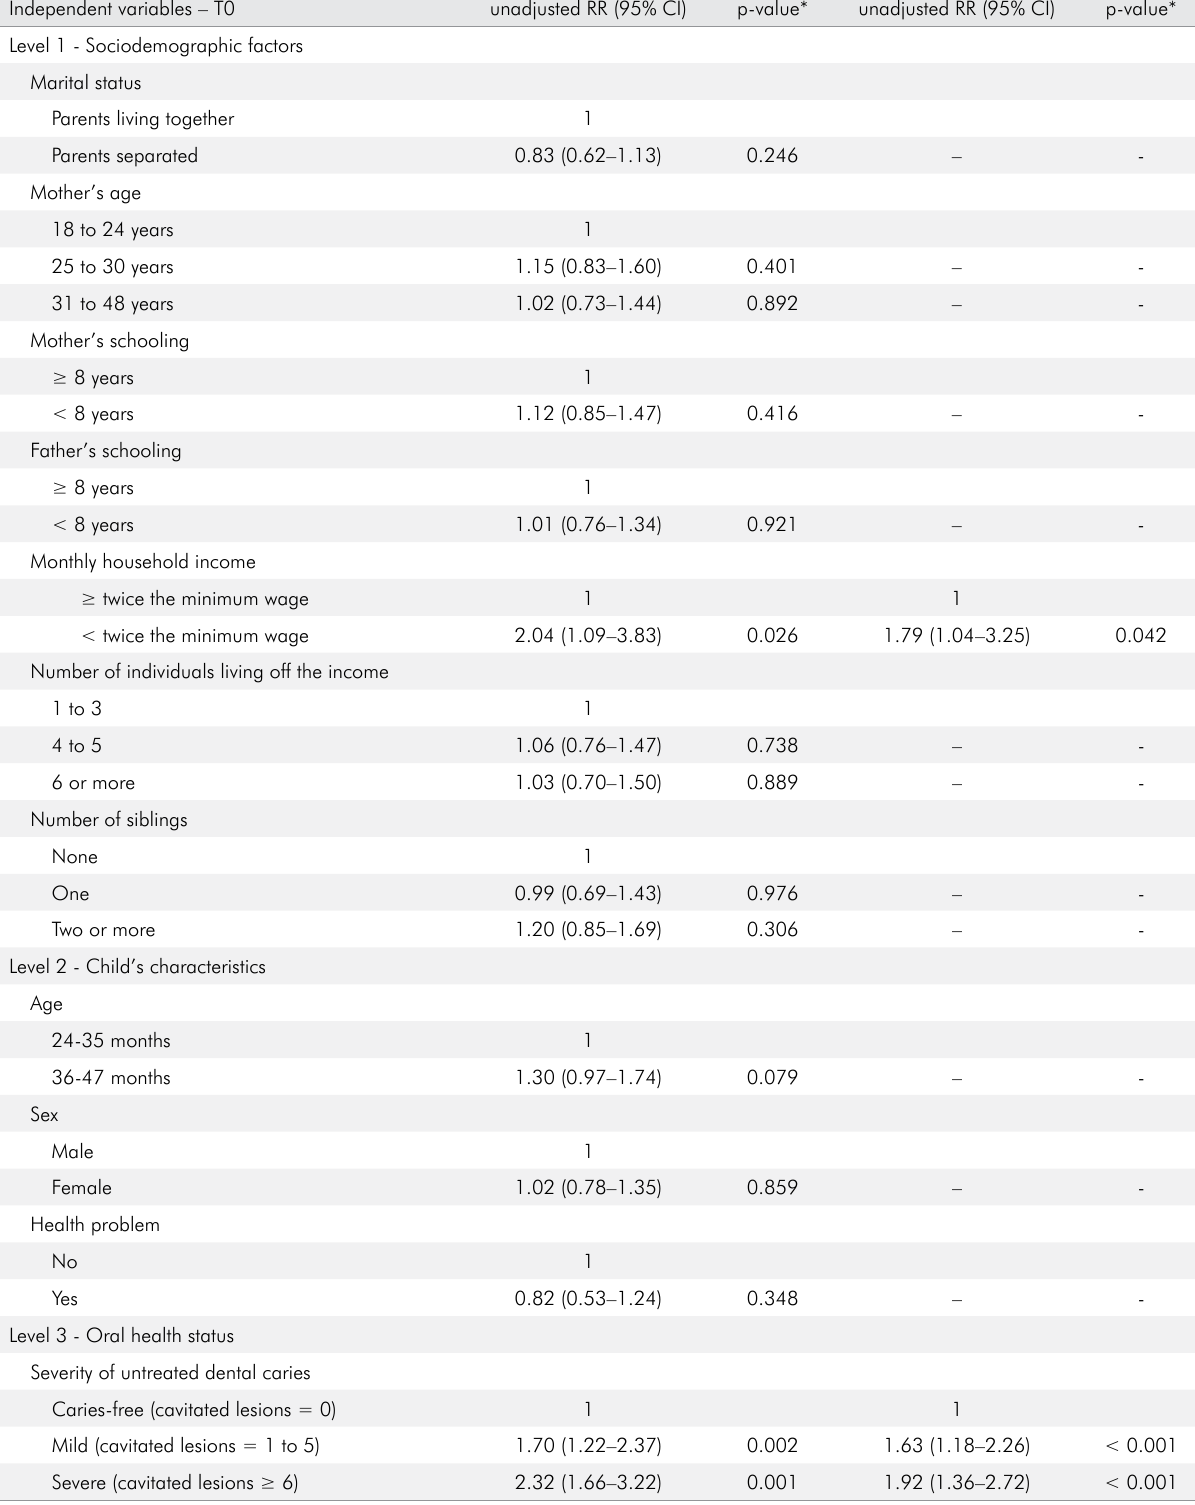
Table 4. Univariate regression and final analyses with hierarchical model for associations among independent variables evaluated at baseline (T0) and presence of new lesions of untreated dental caries in preschool children in the second examination